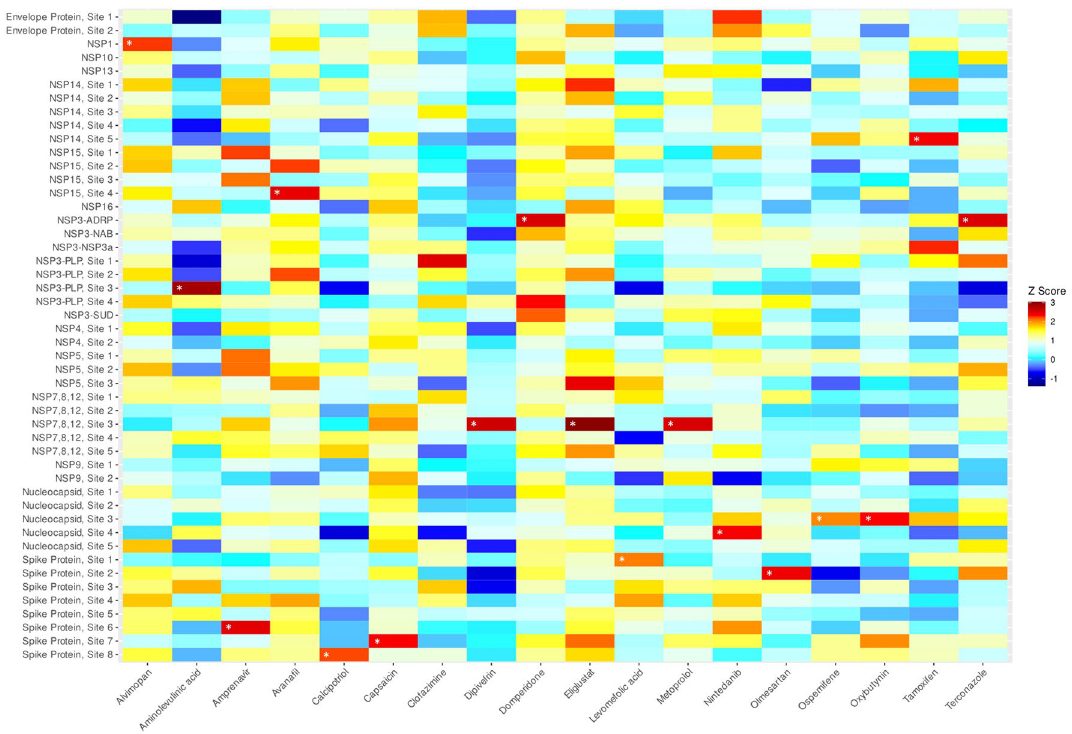
Figure 3. Heat map of hits from composite virtual screening campaign. Under our prioritization scheme, 17 high confidence, FDA-approved drugs were predicted to interact in 34 unique drug-site combinations. White asterisks denote the systems selected for molecular dynamics simulations. The heat map was generated with R language using the ggplot2